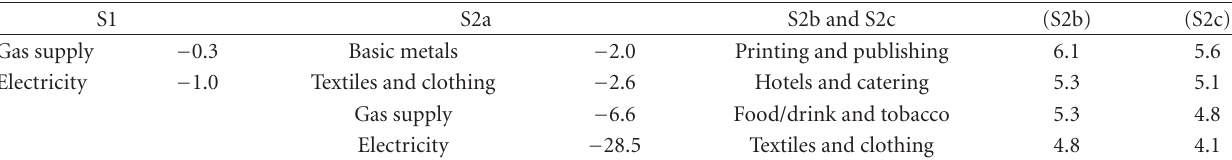
Table 5: Real output e ff ects, selected sectors.